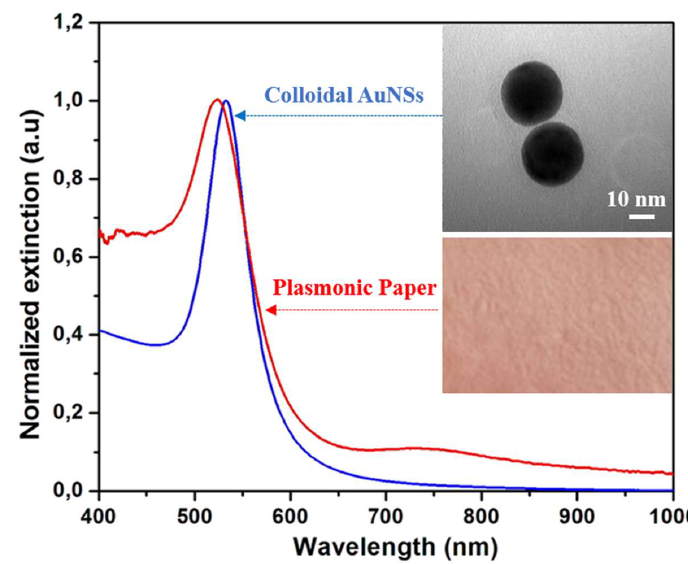
Figure 1. The normalized extinction spectra of the AuNSs before and after their immobilization onto the paper substrate. Inset upper-right: A representative TEM (transmission electron microscope) image of the as-synthesized AuNSs. Inset lower-right: A digital photograph of the paper substrate after the immobilization of the AuNSs.